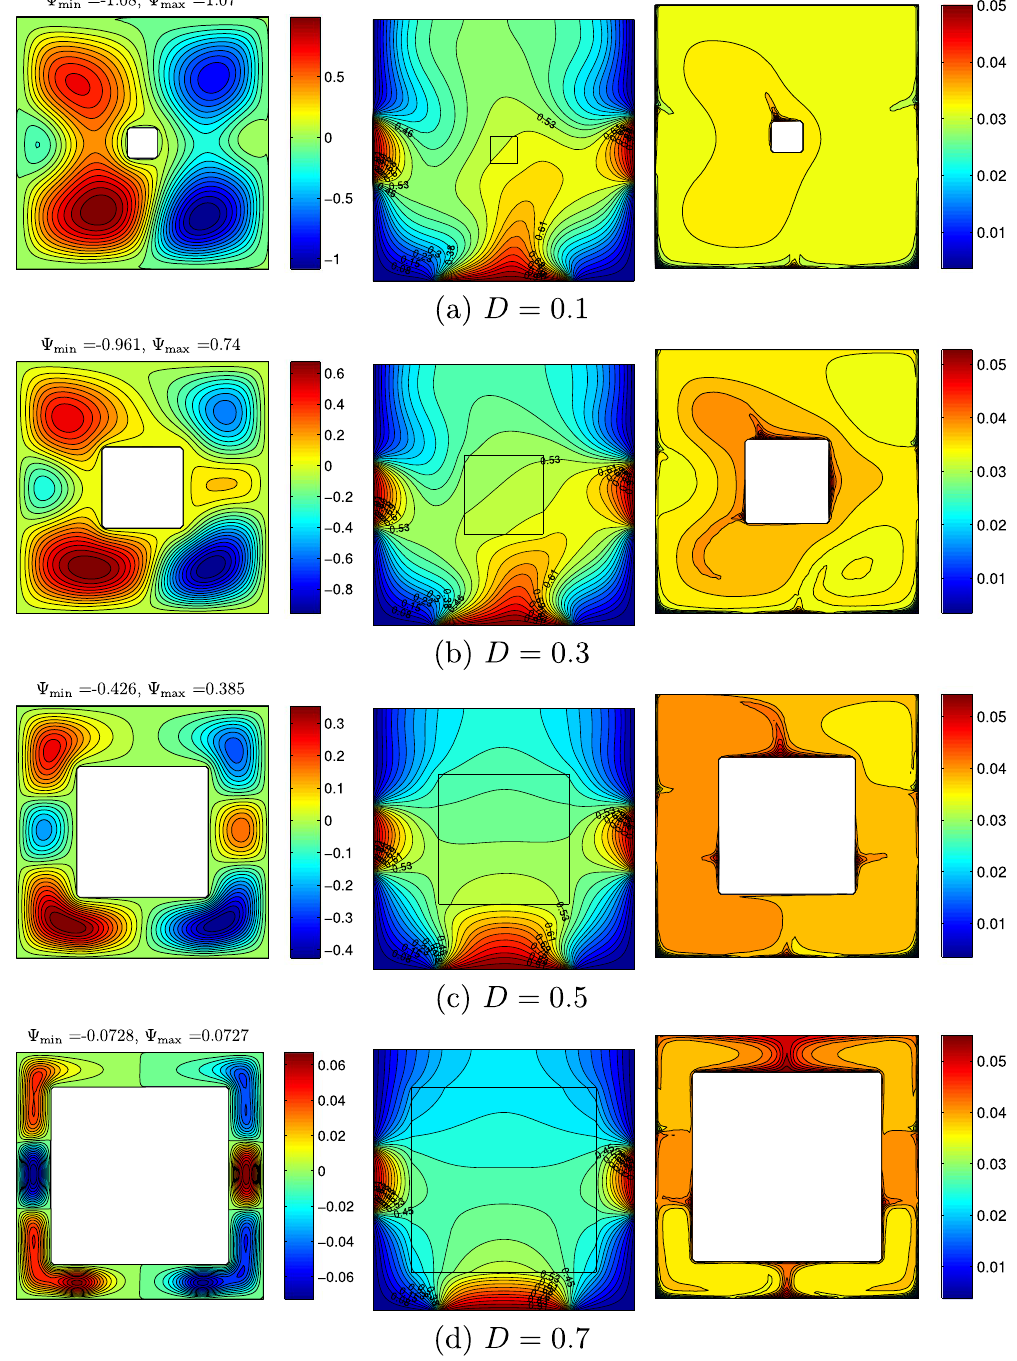
Figure 19. Variation of the streamlines (left), isotherms (middle), and nanoparticle distribution (right) evolution by length of the conductive inner block ( D ) for Ra = 10 5 , φ = 0.02, Ha = 15 and k w =